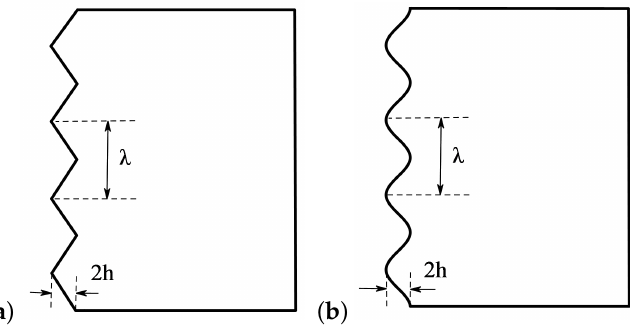
Figure 4. Schematic of the leading edge serrations showing the parameters of wavelength λ and amplitude h : ( a ) sawtooth serrations; and ( b ) sinusoidal